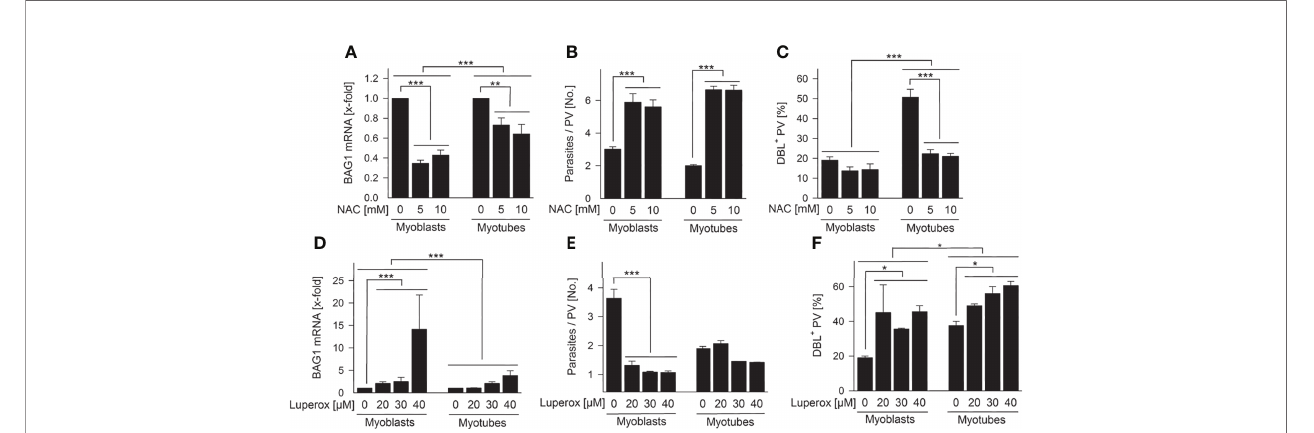
FIGURE 7 | Intracellular ROS regulate T. gondii bradyzoite formation in SkMCs. C2C12 myoblasts and in vitro -differentiated myotubes were treated with N-acetyl cysteine (NAC; A – C ) or tert-butyl peroxide (Luperox; D – F ) or were mock-treated as indicated. One hour later, they were infected with T. gondii . (A, D) After isolation of total RNA at 48 hours of infection and after reverse transcription, T. gondii BAG1 and T. gondii actin mRNAs were quantitated by real-time PCR. Bars indicate the treatment-induced regulation of BAG1 mRNA as compared to mock-treated controls and normalized to actin mRNA (means ± S.E.M., n ≥ 3). (B, E) Alternatively, cells were fi xed at 48 hours after infection, and parasites and SkMCs fl uorescently labelled using T. gondii -speci fi c antibodies and propidium iodide, respectively. The average number of parasites per parasitophorous vacuole (PV) was determined from 100 PVs; results indicate means ± S.E.M. (n ≥ 2). (C, F) After cells were fi xed at 72 hours post infection, T. gondii tissue cysts were labelled with Dolichos bi fl orus lectin (DBL), total parasites were labelled using a T. gondii -speci fi c antiserum, and host cells were visualized using propidium iodide. The percentage of DBL-positive tissue cysts was determined in 100 T. gondii PVs; results indicate means ± S.E.M. (n ≥ 2). (A – F) Signi fi cant differences were identi fi ed by ANOVA (* p < 0.05; ** p < 0.01; *** p <